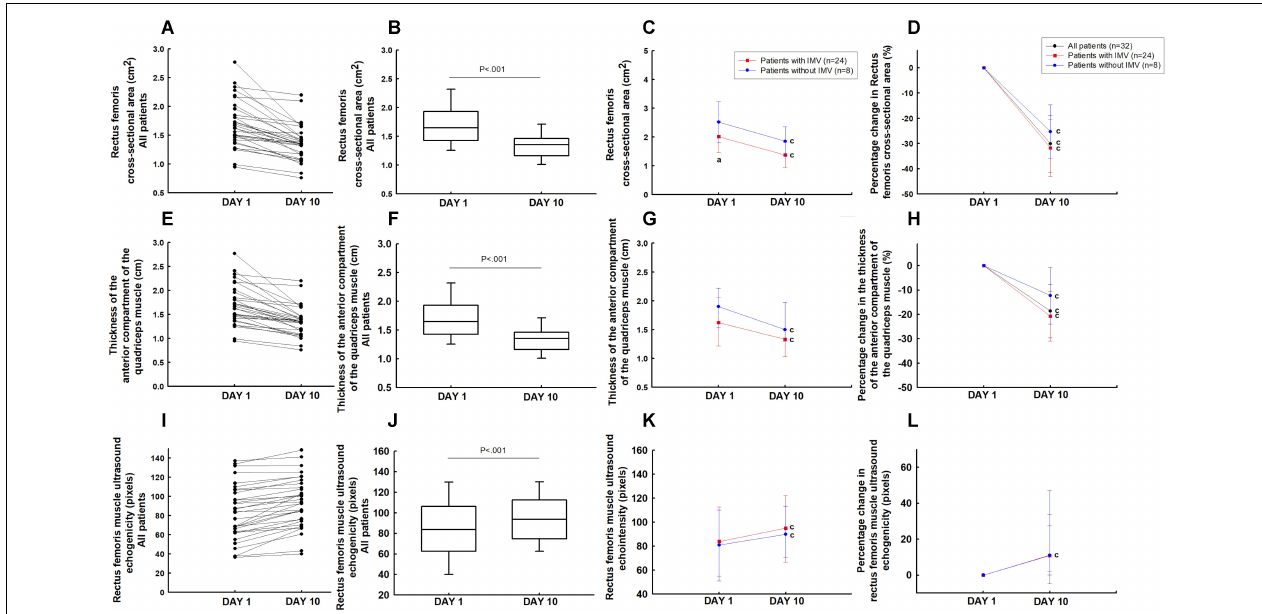
FIGURE 2 | Ultrasound muscle assesses the rectus femoris cross-section area (A–D) , the thickness of the anterior compartment of the quadriceps muscle (rectus femoris and vastus intermedius) (E–H) , and rectus femoris echogenicity (I–L) . a P < 0.05 vs patients without IMV on day 1; c P < 0.05 vs day 1.